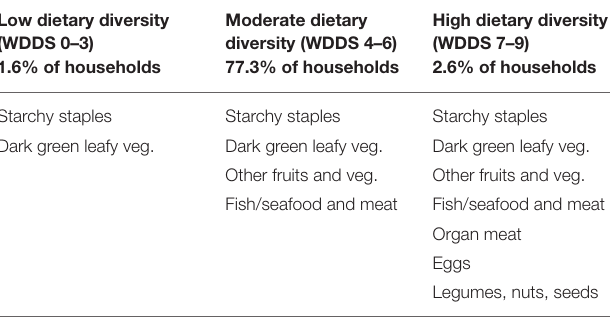
TABLE 4 | Foods characterizing diets with low, moderate, and high diversity using a WDDS scale † . Low dietary diversity (WDDS 0–3)